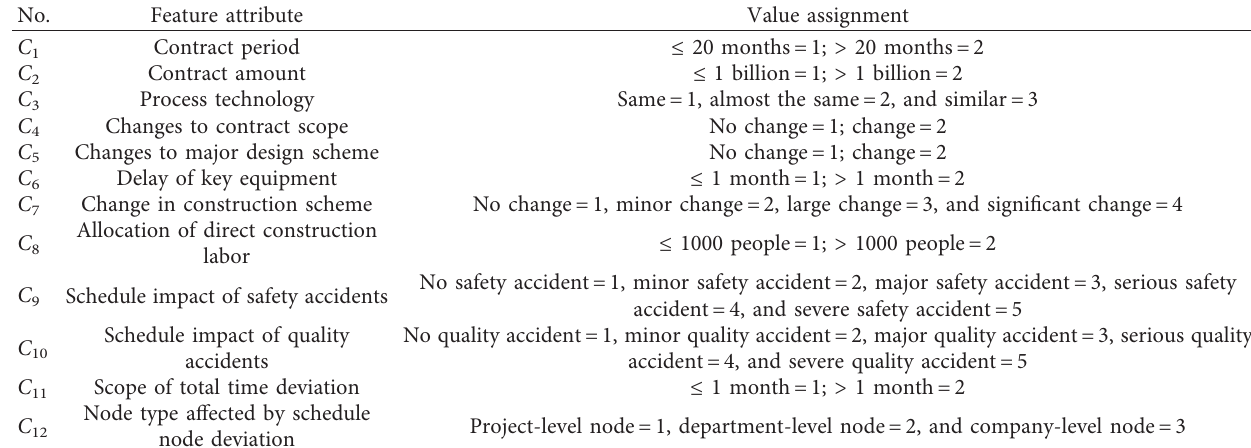
Table 1: Feature attributes and value assignments for industrial project scheduling control.